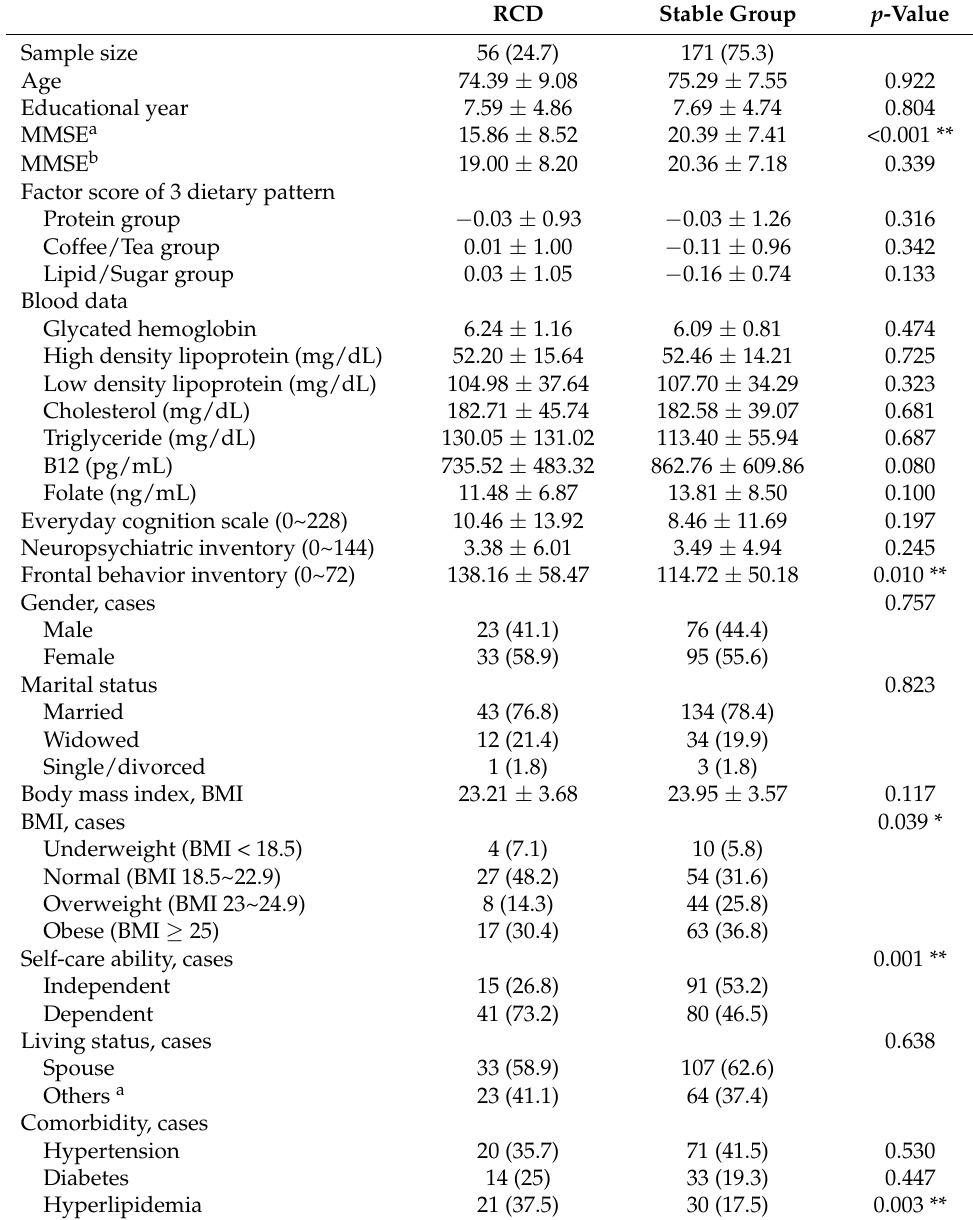
Table 4. Factors related to rapid cognitive decline in Alzheimer’s